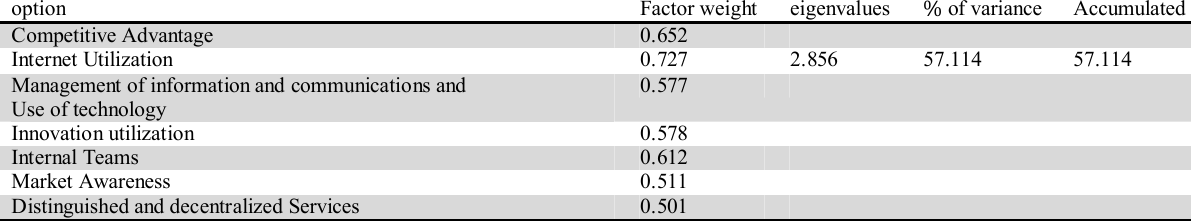
The summary of factors associated with environment opportunities option